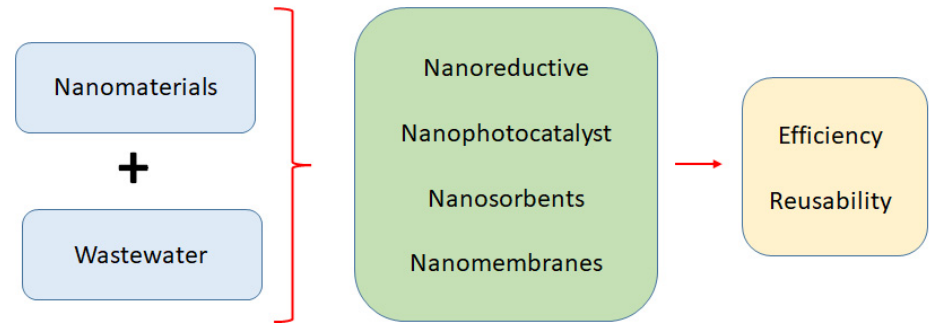
Figure 1. Nanomaterials and processes in the wastewater treatment.